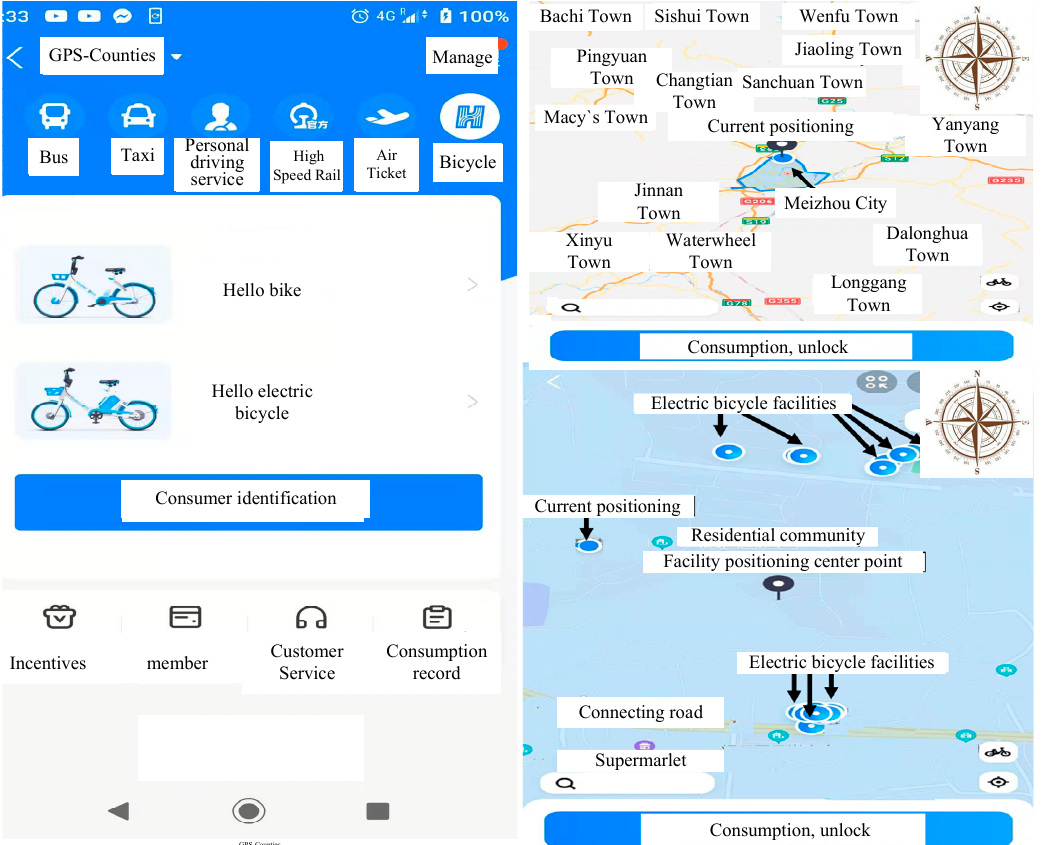
Figure 1. Description of the operation interface between an e-bike sharing system and mobile phone.